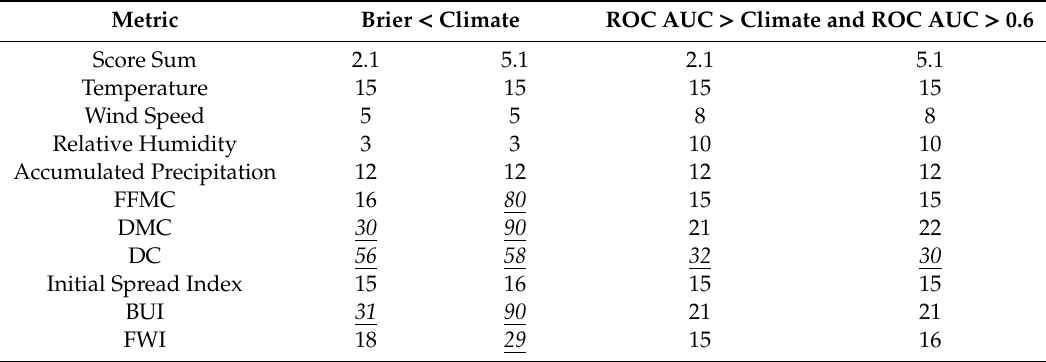
Table 2. Number of days for which our weather and fire weather forecasts are better than climatology as a forecast, based on Brier Score and ROC AUC > 0.6, for Score Sums 2.1 and 5.1. Italic numbers represent coverage to at least the 50th percentile of monitored fire duration (29 days). Brier < Climate ROC AUC > Climate and ROC AUC > 0.6